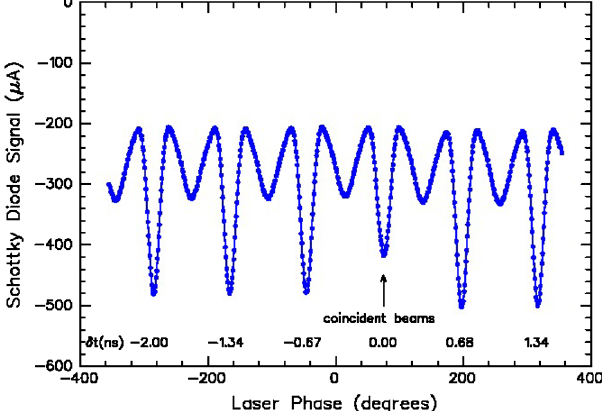
FIG. 8. Current from the zero-bias Schottky diode as one electron bunch train was passed across the other by varying the RF-phase of one drive laser. Both beams were produced using lasers with 249.5 MHz pulse repetition rate. The prominent dips corresponds to precise time intervals between bunches, n × 668 ps. The dip with smallest magnitude corresponds to bunches coincident in